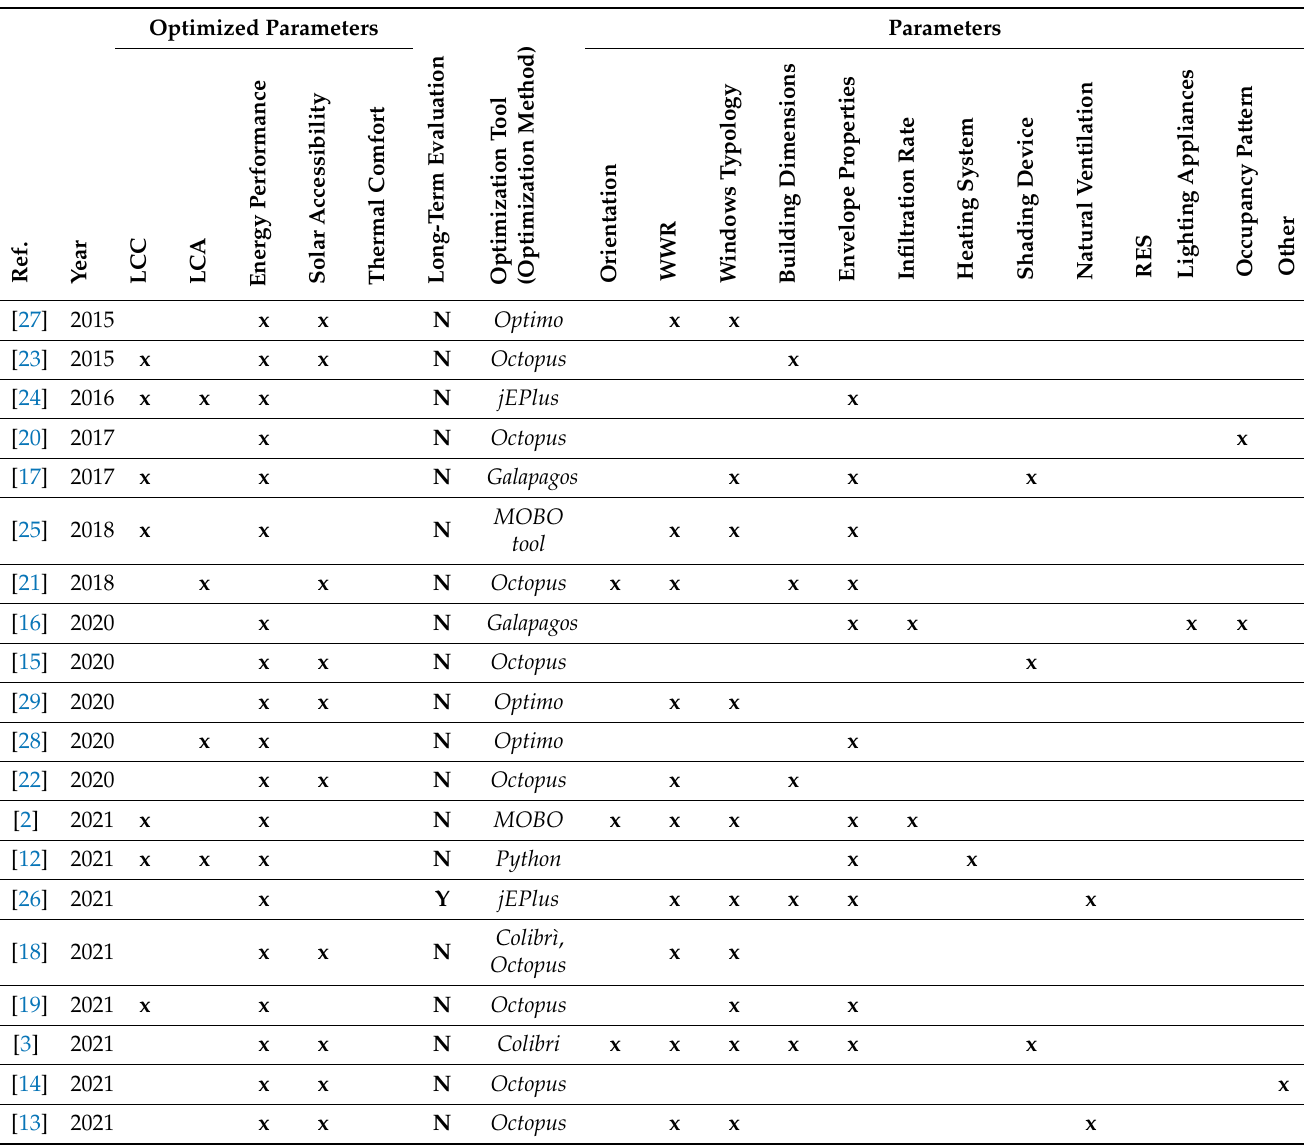
Table 3. Tabular review of journal articles about Python-based MOO